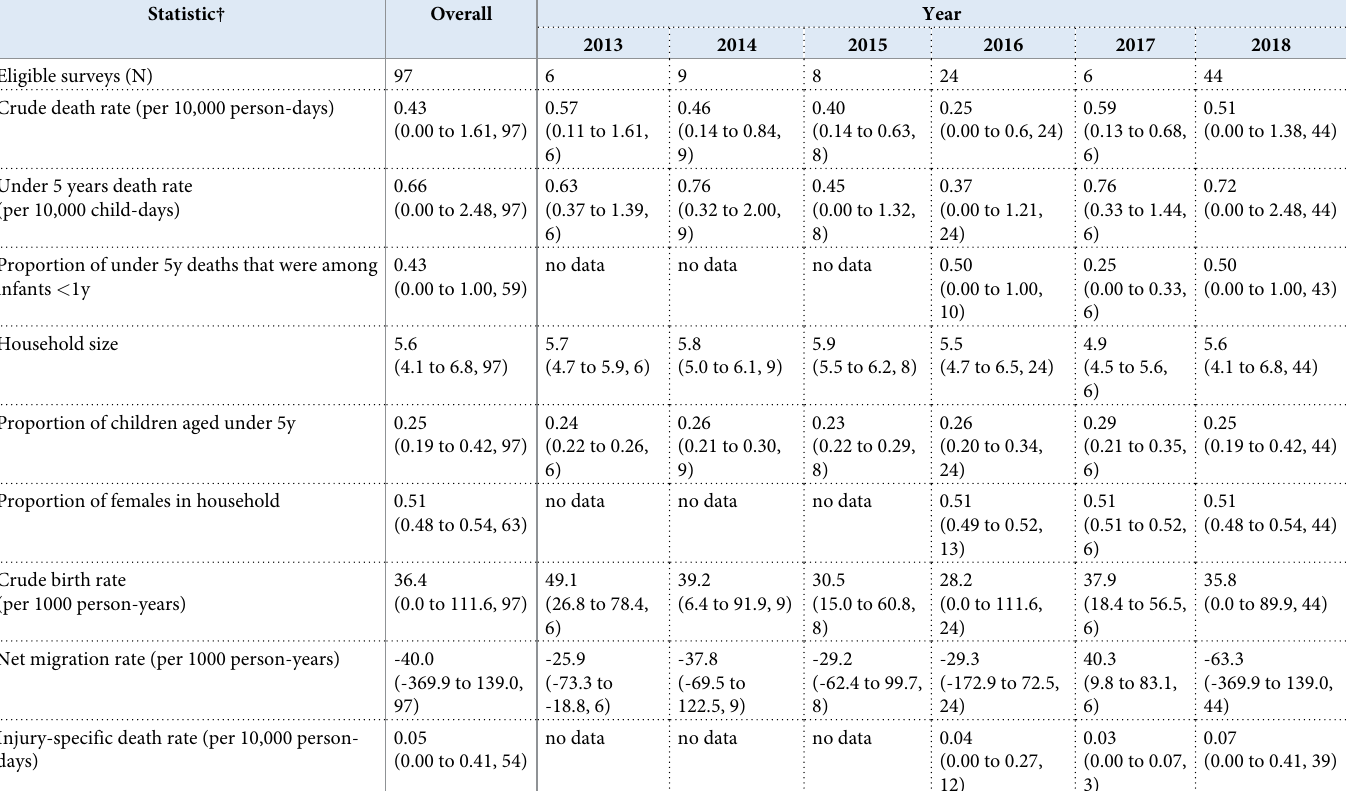
Table 3. Crude summary statistics for eligible mortality surveys, overall and by